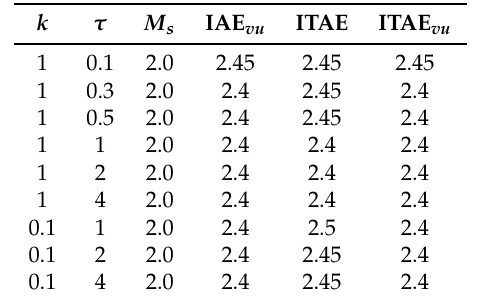
Table 4. Consider PI controller settings for an IPTD system, H p ( s ) = k e − τ s k , and time delay τ ≥ 0. The table illustrates the ¯ c min = arg min IAE vu , ITAE and ITAE vu indices as a function of ¯ c , with PI controller settings from Algorithm